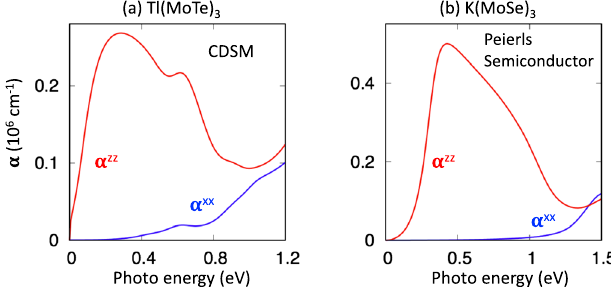
FIG. 5. Absorption coefficient ( α xx ¼ α yy ; α zz ) of (a) Tl ð MoTe Þ 3 and (b) K ð MoSe Þ 3 from DFT